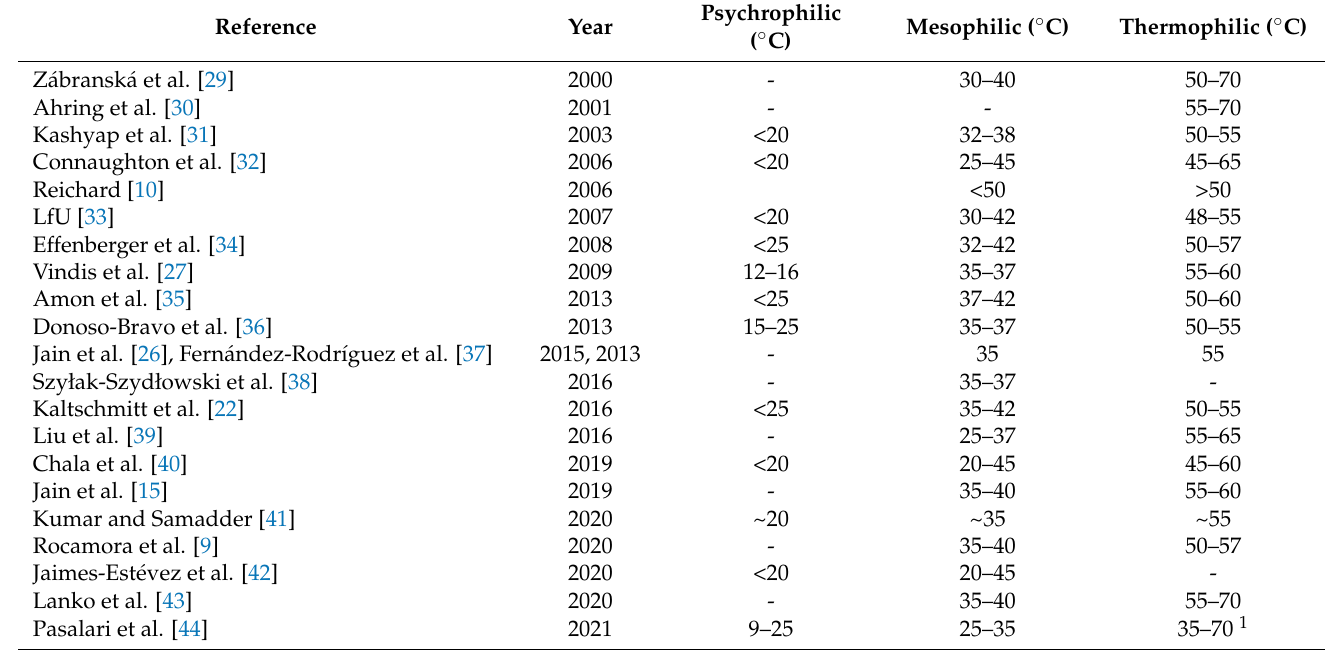
Table 1. Temperature ranges and optima in technical anaerobic digestion processes according to different